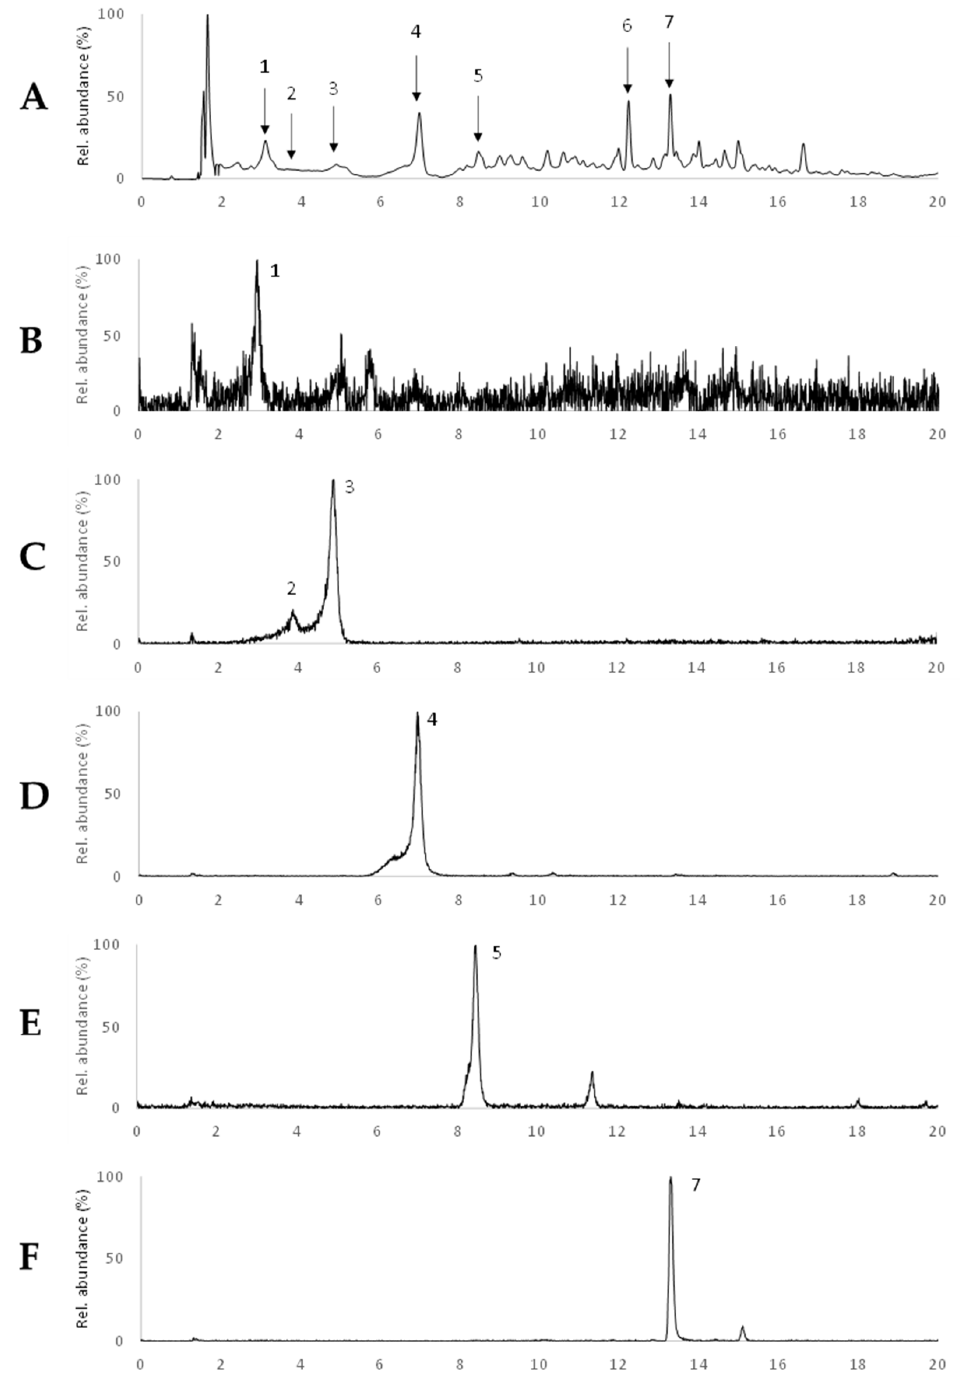
Figure 6. UV chromatograms recorded at 280 nm ( A ) and extracted ion chromatograms (EICs) of the major compounds detected in F5, namely m/z at 621 ( B ) m/z at 745 ( C ), m/z at 479 ( D ), m/z at 369 ( E ) and m/z at 507 ( F ). Peaks marked with numbers correspond to the tentatively identified compounds listed in Table 1.